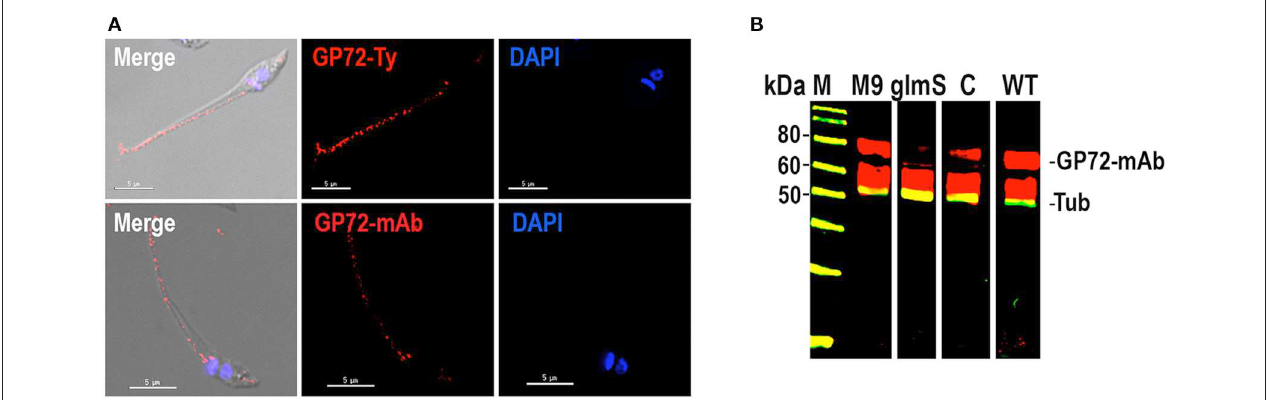
FIGURE 3 | Complementation of TcGP72-3xHA-glmS . (A) Immunofluorescence microscopy of TcGP72-3xHA-glmS epimastigotes complemented with an exogenous copy of TcGP72 gene. Labeling of the flagellum was detected with anti-Ty and WIC 29.26 antibodies, while no flagellar detachment was observed. Bars = 5 µ m. (B) Western-blot analysis of total protein extracts of TcGP72-3xHA-M9 (M9) , TcGP72-3xHA-glmS (glmS), TcGP72-3xHA-glmS complemented with TcGP72-Ty (lane C) and wild type (WT) epimastigotes, using WIC 29.26 antibodies. Anti- α -tubulin antibodies (Tub) were used as a loading control.